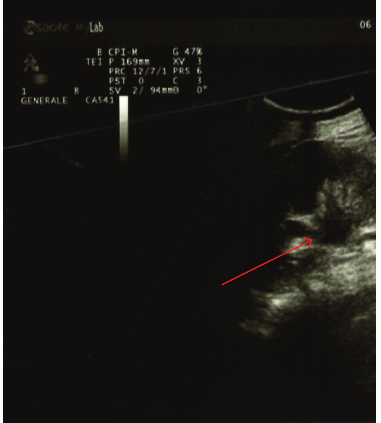
Figure 3: Left hydronephrosis.